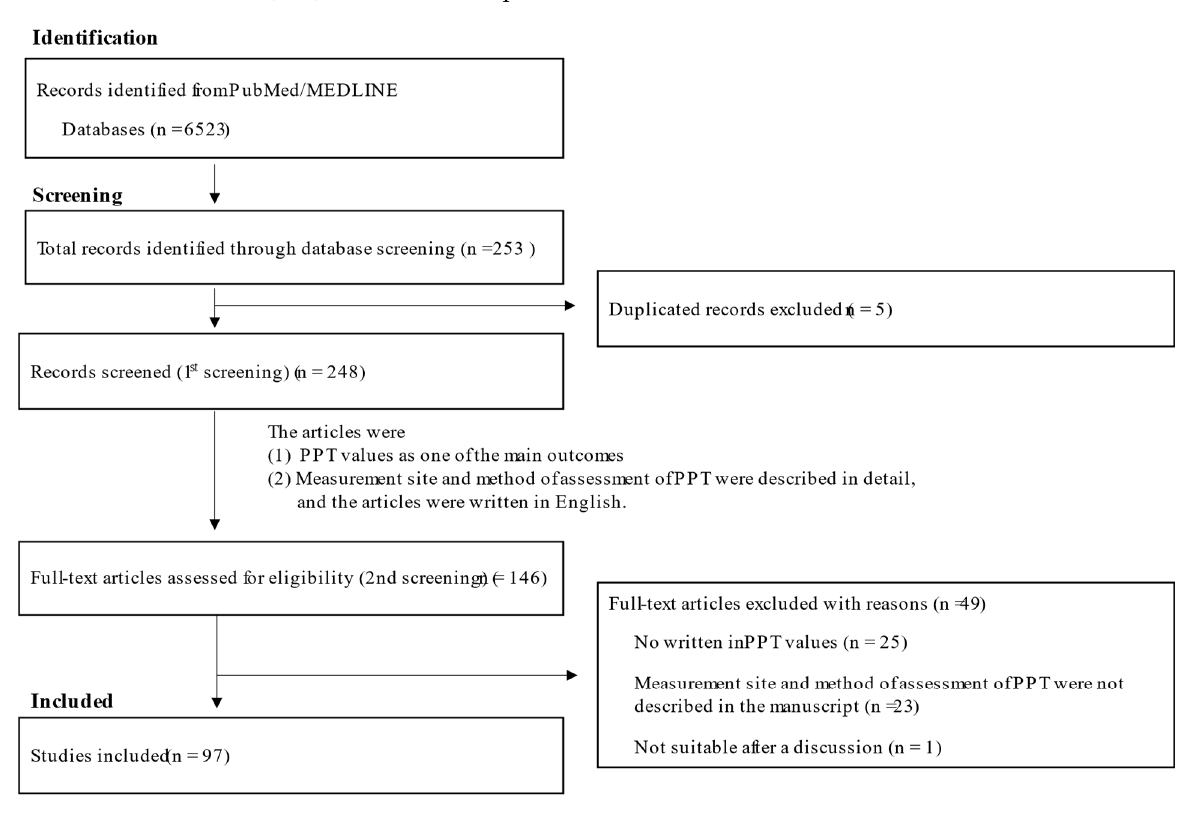
Figure 1. Flowchart of references—screening process in this systematic